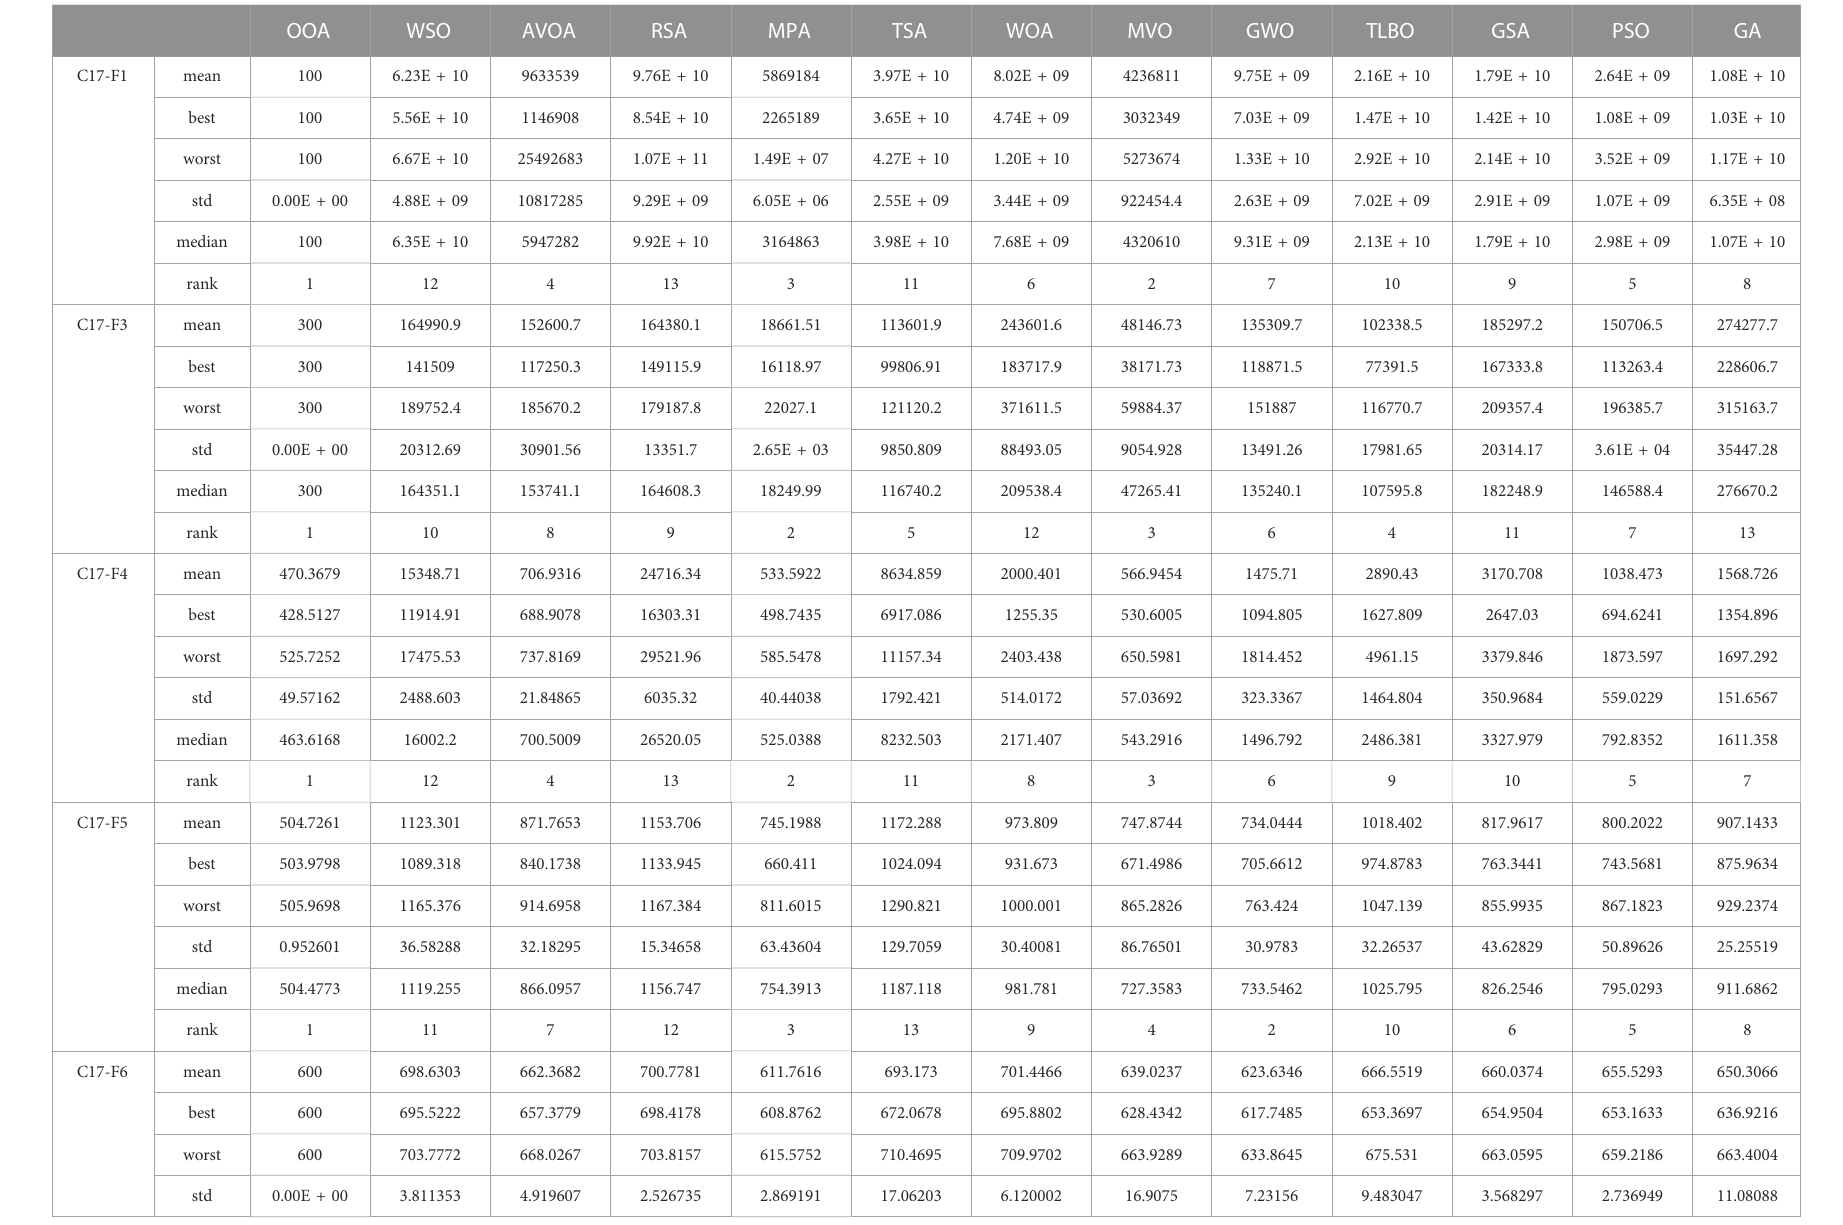
TABLE 4 Performance of optimization algorithms on the CEC 2017 test suite ( D (cid:1)